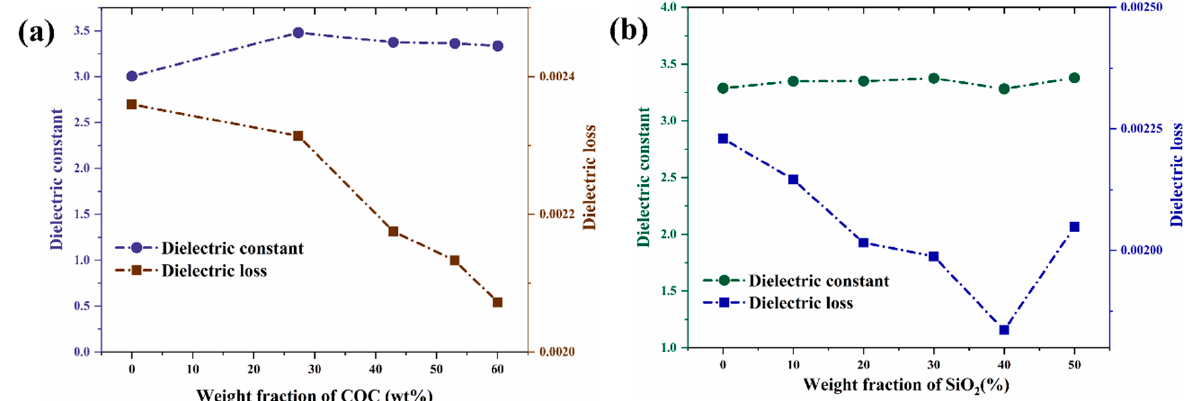
Figure 4. Influence of the content of COC ( a ) and SiO 2 ( b ) on D k and D f at 10 GHz.